Question: Describe this figure in one sentence.
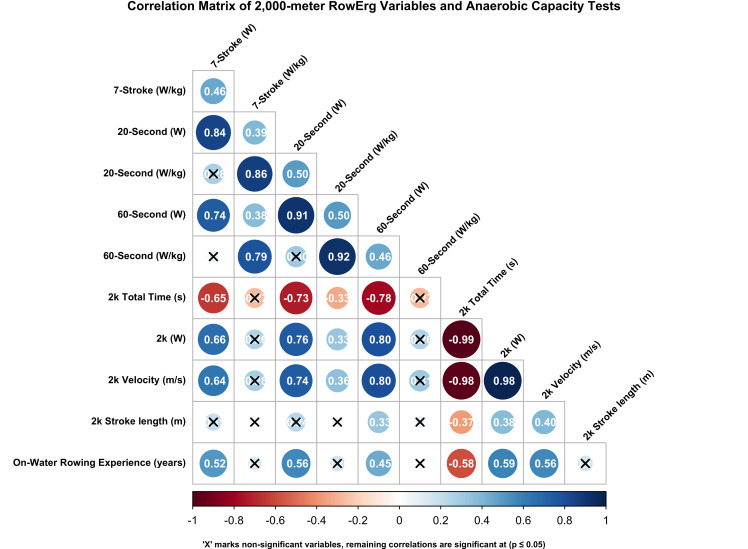
Answer: Heatmap correlation matrix.